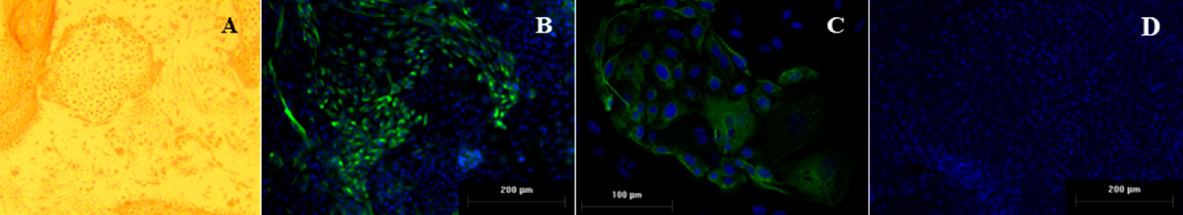
Figure 1. Phase contrast and immunofluorescence photomicrographs of bovine mixed endometrial and stromal cells. ( A ) Epithelial colony surrounded by stromal cells. ( B ) With anti-vimentin antibody, stromal cells were specifically stained with fluorescent (green) with Hoechst labeling of the nuclei (blue). ( C ) With anti-cytokeratin antibody, epithelial cells were specifically stained with fluorescent (green). ( D ) Representative images of negative control of primary antibody used in this study.